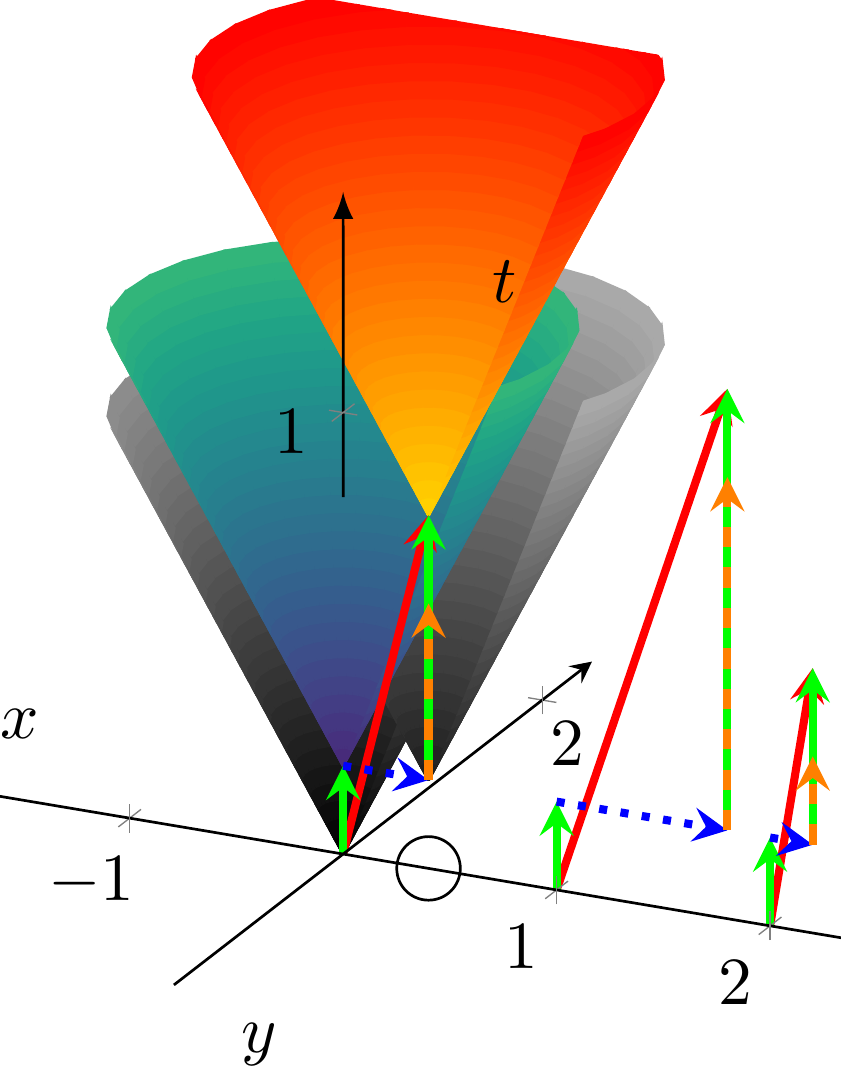
Figure 4. The computing operation in time–space approach. The processing operators can be gates, processors, neurons, or networked computers. The “idle waiting time”, rooting in the finite interaction speed and the physical distance of computing elements (see mixed-color vectors in figure), is one of the major sources of computing systems’